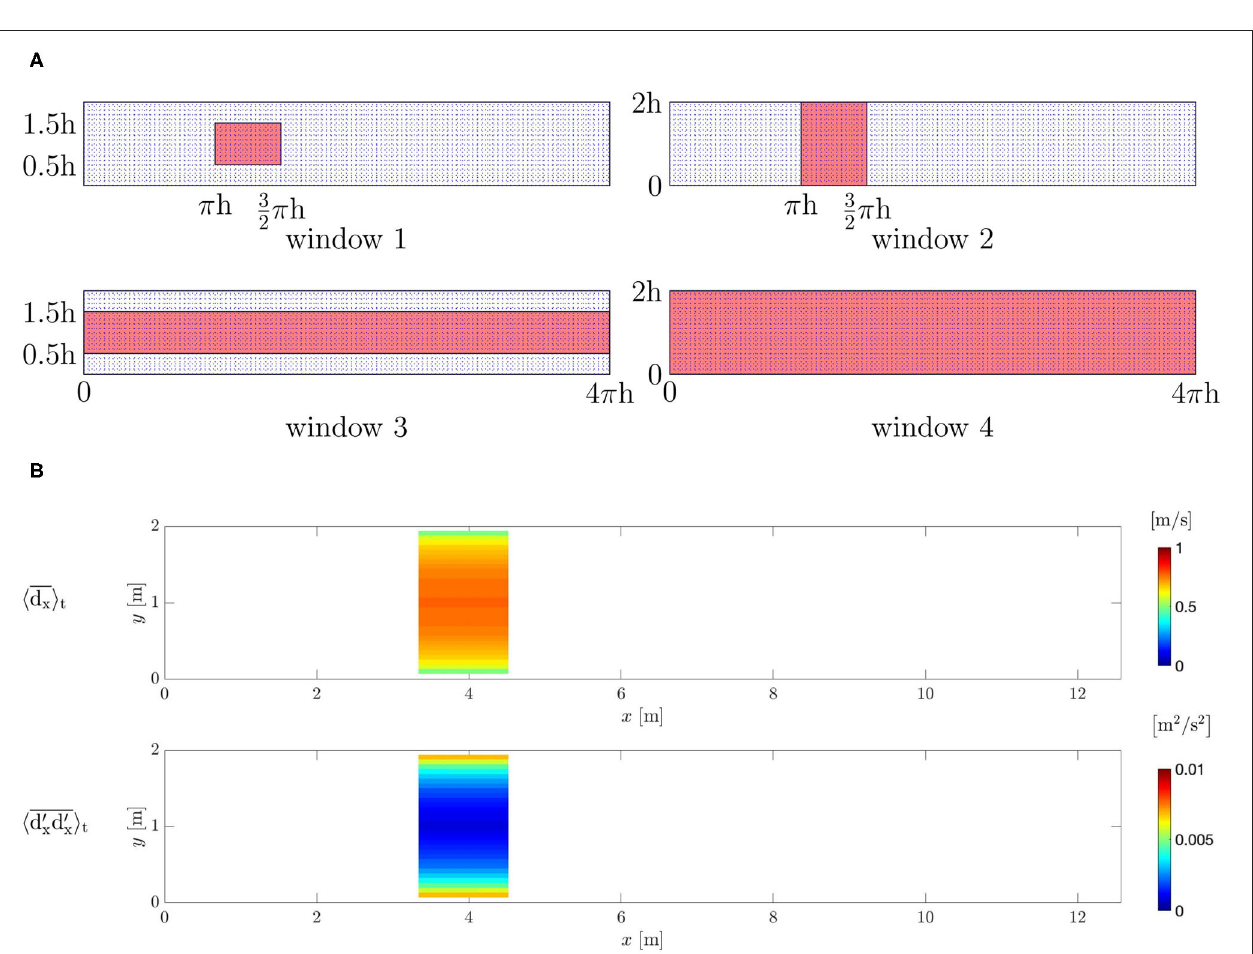
for all the DA predictions and the more visible differences with respect to the ground truth are in the amplitude of